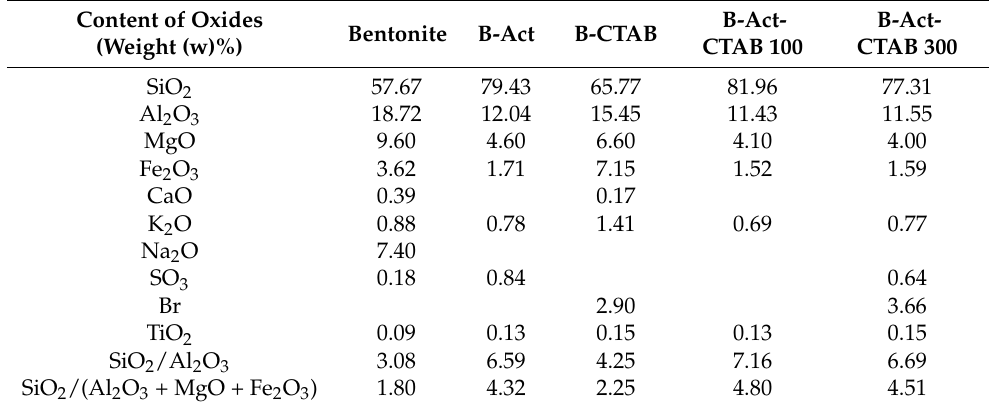
Table 1. Chemical composition of Bentonite and all modified Bentonites (B-Act, B-CTAB, B-Act- CTAB100 and B-Act-CTAB300).